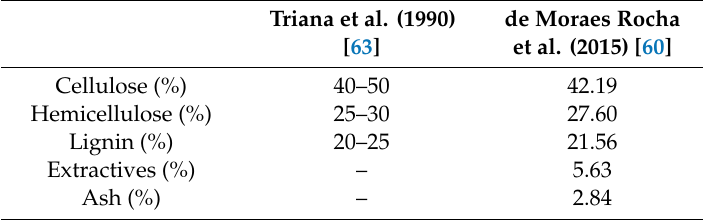
Table 2. Typical composition of sugarcane bagasse.